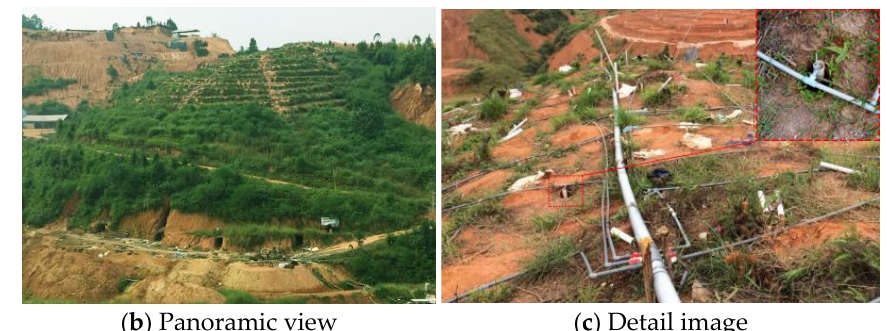
Figure 8. Layout of monitoring points in the testing site.